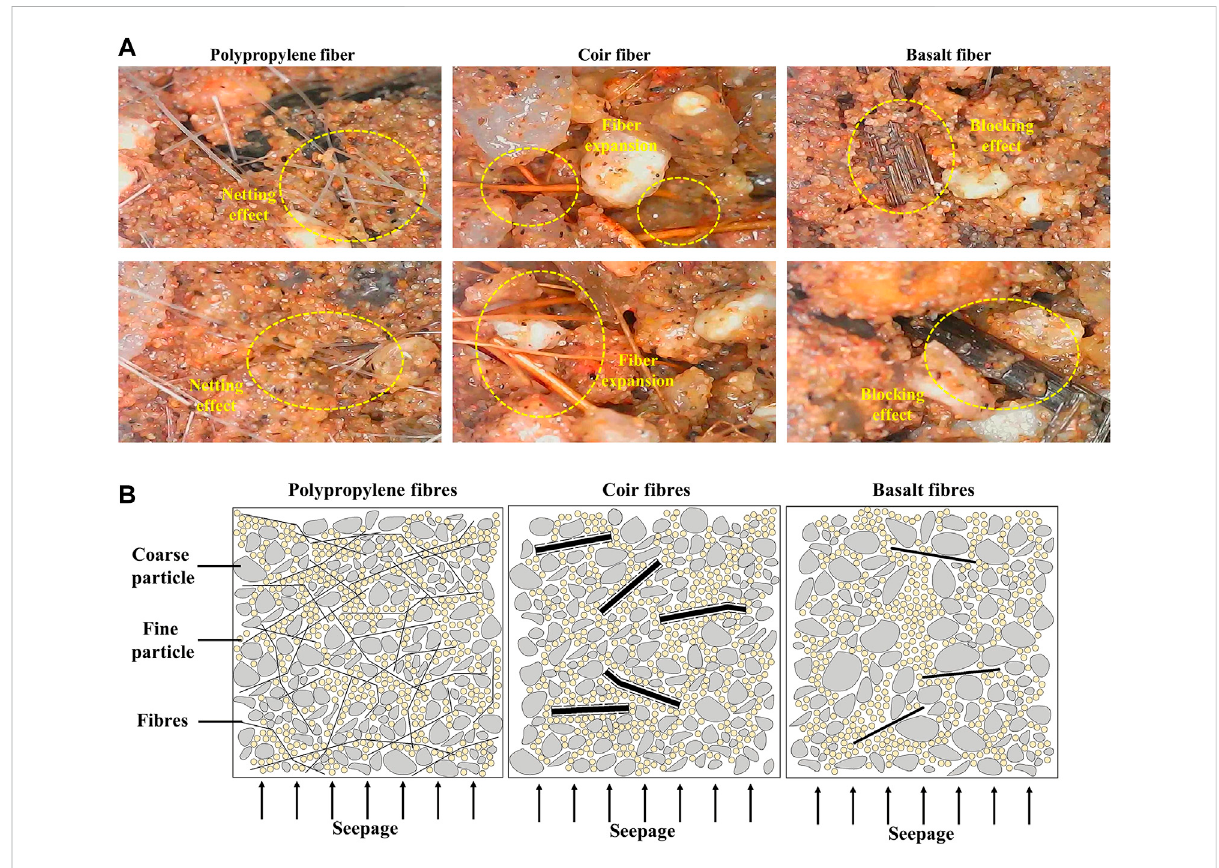
FIGURE 5 Reinforcement mechanisms: (A) microscope photographs; (B) schematics.